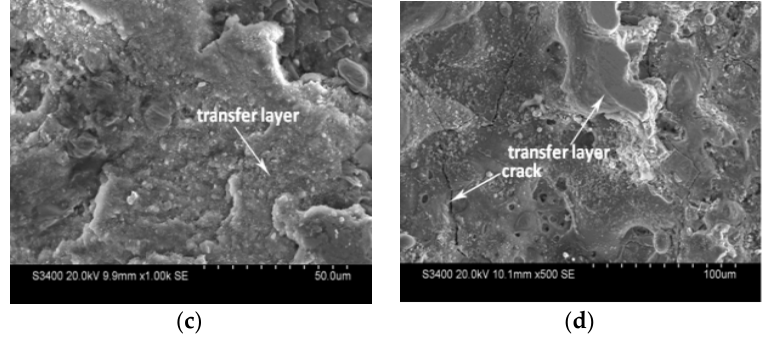
Figure 8. Worn surface of a pin: ( a ) 20TiB 2 ‐ NiCr; ( b ) 40TiB 2 ‐ NiCr; ( c ) 60TiB 2 ‐ NiCr; and ( d ) Cr 3 C 2 ‐ 25NiCr.